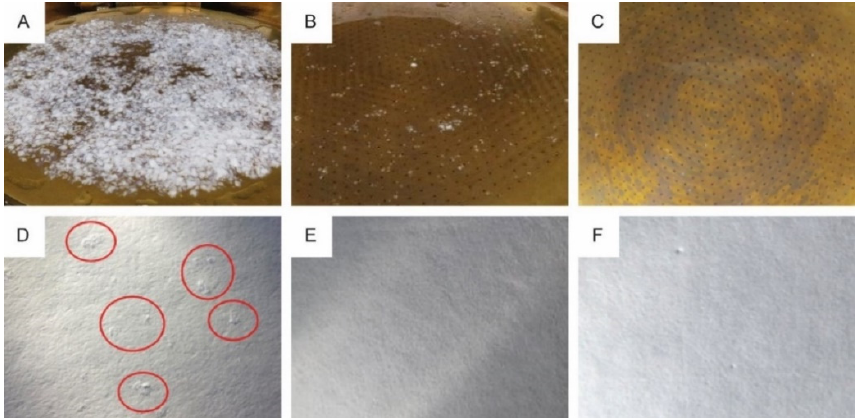
Figure 12. 0.7 mm hole reject ( A – C ) and sheet adhesion test results ( D – F ) of p_e:smart paper type 2 ( A , D ), Algro Baress ( B , E ) and Magno Satin ( C , F ), respectively. The reject of p_e:smart paper type 2, Algro Baress and Magno Satin amounted 56.0 m%, 0.7 m% and 0.8 m%, respectively. The reject of p_e:smart paper type 2 consisted of